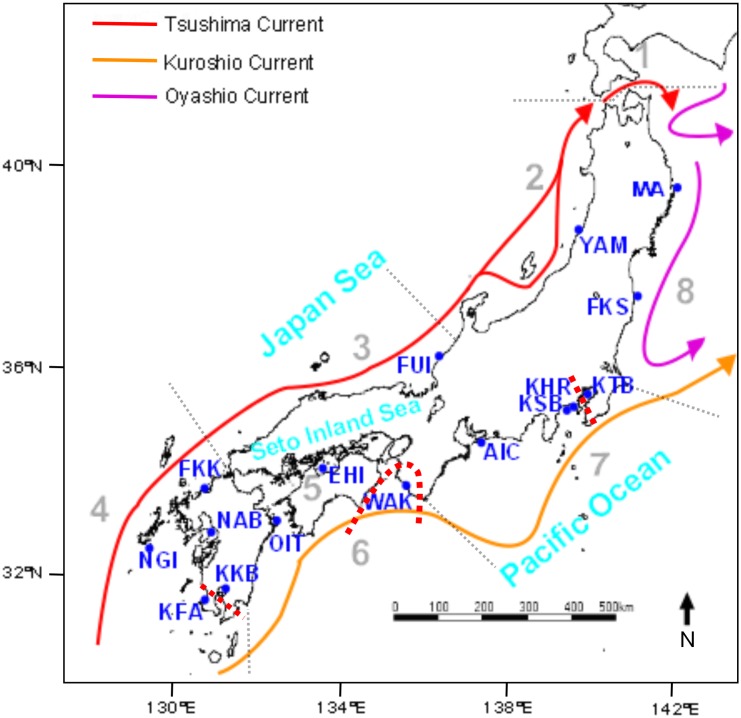
Sampling locations (solid circles, for details see Table 1) and main circulation features associated with major water masses around the Japanese archipelago.Broken red lines indicate the location of the three major barriers to gene flow inferred based on the microsatellite data. Broken grey lines delimit the eight coastal regions dividing the country: 1. Hokkaido, 2. Northern Japan Sea, 3. Western Japan Sea, 4. East China Sea, 5. Seto Inland Sea, 6. Southern Pacific, 7. Central Pacific, 8. Northern Pacific.